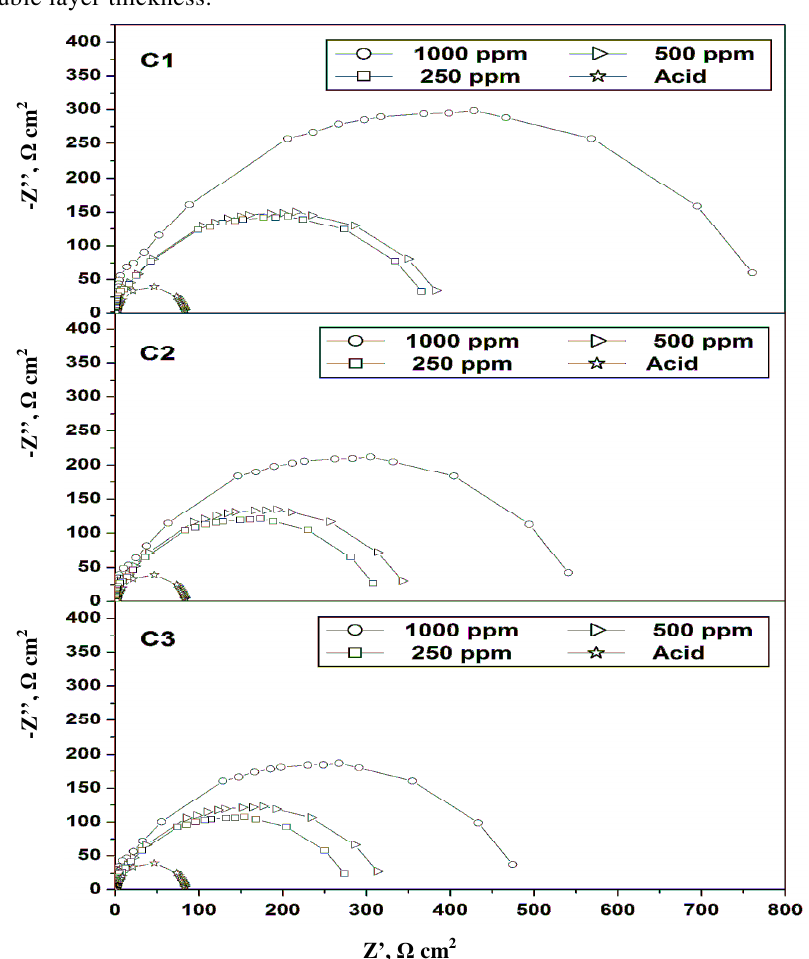
Figure 3. Nyquist plot for different concentrations of inhibitors in 0.5 N